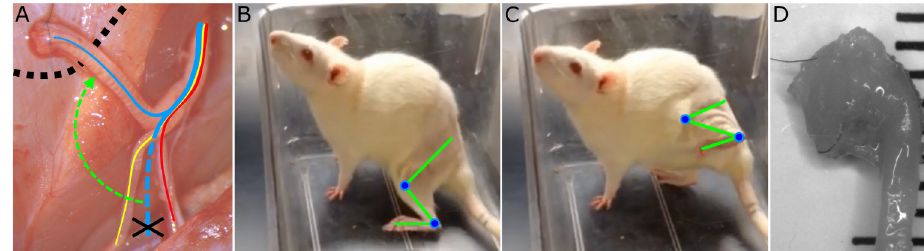
Fig 1. The modified tibial neuroma transposition (TNT) surgery and RF EMF behavioral response assays. (A) Depiction of the TNT surgery. The three distal branches of the sciatic nerve (tibial: blue, sural: red, and common peroneal: yellow) were teased from the surrounding connective tissue and from each other. The tibial branch was then transected (black X) and transposed from its original (dashed blue line) to its final orientation (solid blue line), and sutured to the fascia adjacent to the hip bone (black dashed line). TNT surgery resulted in neuroma formation. (B) 8 week old neuroma bulb. Separation between black lines equals 1 mm. (C) Representative image of a Wistar rat during (C) baseline and (D) stimulus period (10 minutes at 756 ± 8.5 mW/mm 2 ) of the RF EMF (915 MHz) behavioral assay. Animal presents a left hind limb withdrawal. This action represents a response score of 1. (E) Timeline for surgical procedures (S1 and S2) and behavioral response